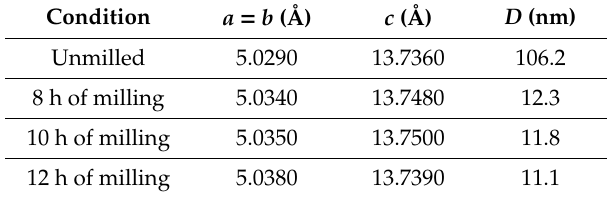
Table 1. Lattice parameters and average crystallite size as a function of milling time.